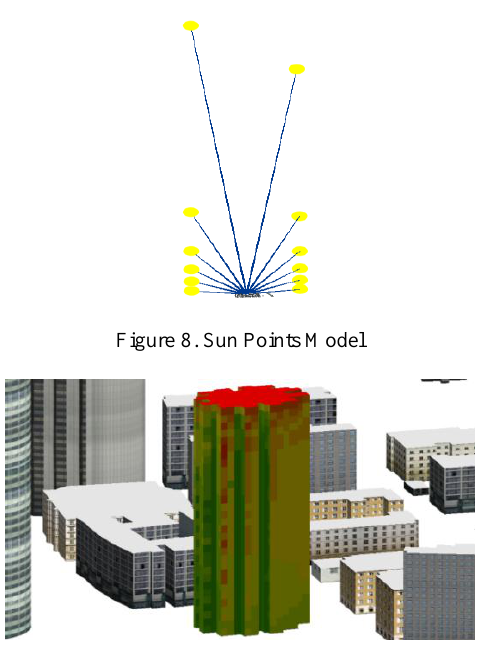
Figure 9. Visualization Effect Chart of Sunlight Analysis